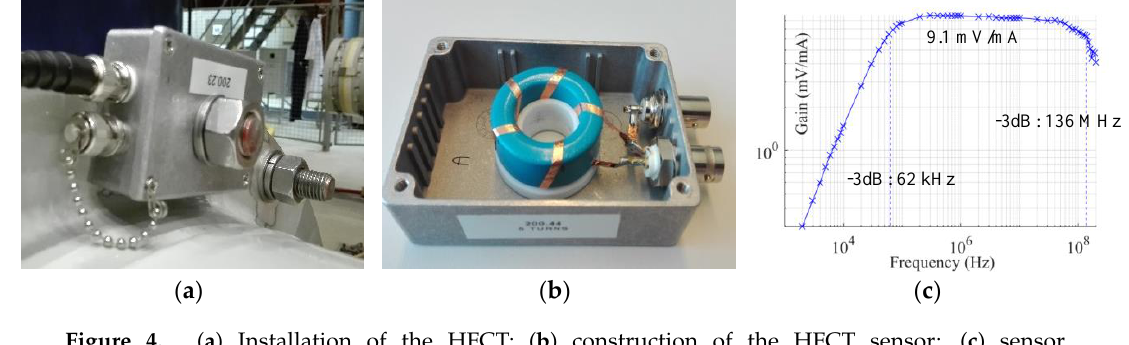
Figure 4. ( a ) Installation of the HFCT; ( b ) construction of the HFCT sensor; ( c ) sensor frequency response.